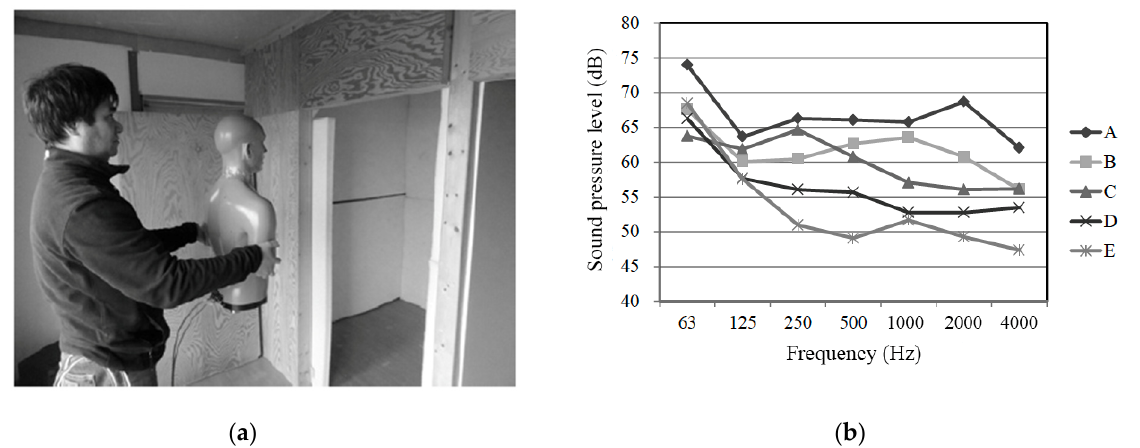
Figure 6. Binaural recording: ( a ) The experimenter holds the dummy head microphone and walks from the front chamber to the evaluation space generating a footstep sound; ( b ) frequency characteristics of the last step for each absorber’s condition.